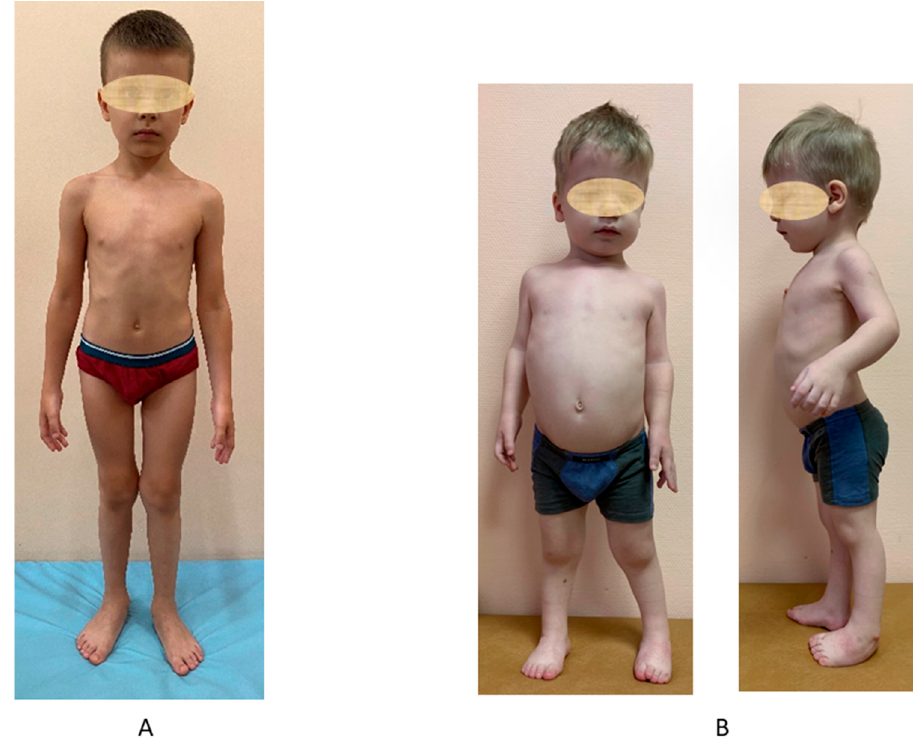
Figure 1. Photos of typical patients with two types of MED type 4. ( A ) A 7-year-old boy with the “late” type c.1957T > A (p.Cys653Ser) homozygous variant—normal body height, mild genua valga, normal hands and feet. ( B ) A 5-year-old boy with the “early” type c.835C > T ( р .Arg279Trp) and c. − 26 + 2T > C compound heterozygous variant—short stature, genua valga, limited elbow exten-